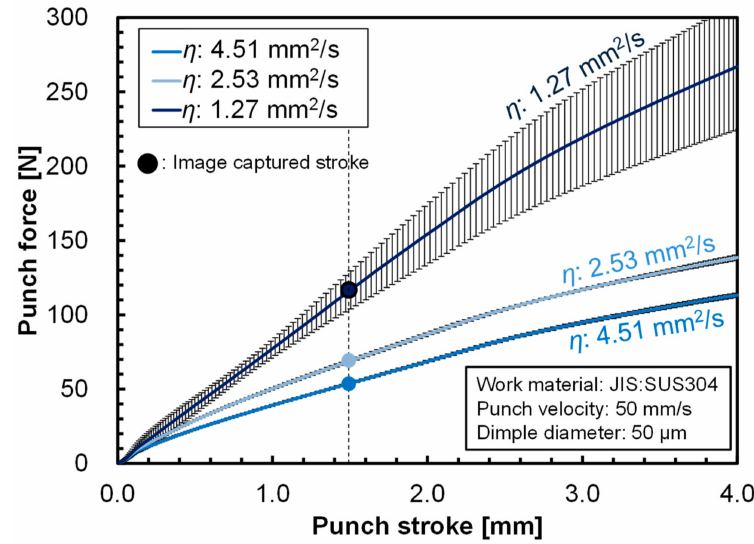
Figure 9. Comparison of punch force–stroke curves between di ff erent lubricant viscosities in bending with the ironing process using the surface textured die with dimple diameters of 50 µ m.